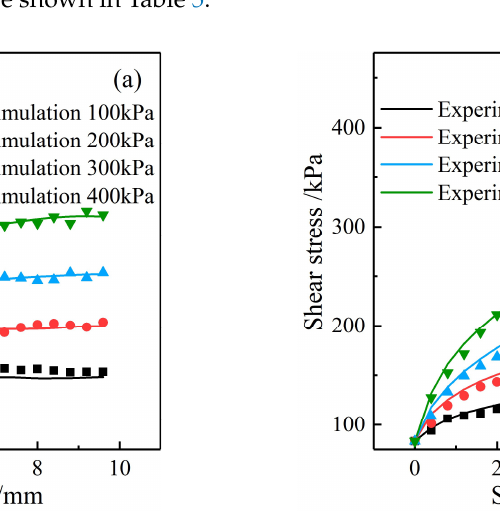
Figure 13.  -  curves: ( a ) N-L; ( b ) 2-L-5. Table 5. Micro-mechanical parameters of numerical model. Type